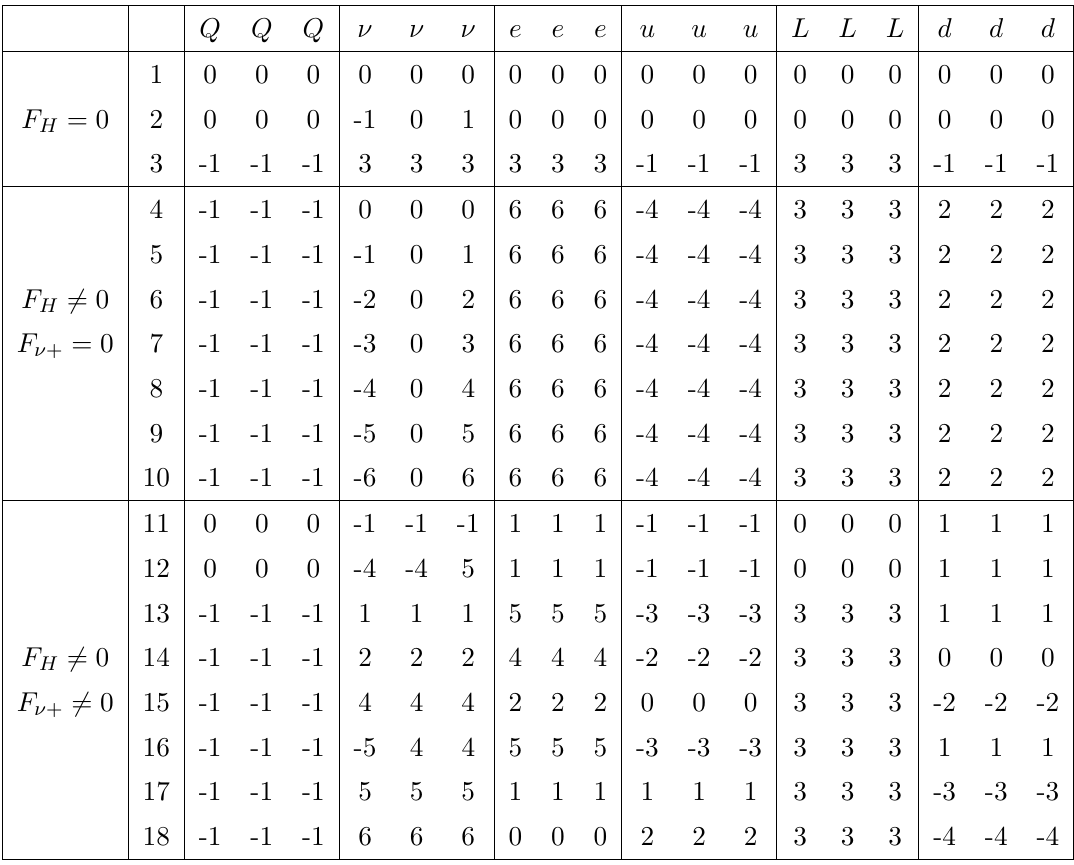
Table 6 . Inequivalent SM (cid:23) R U(1) F charges as output by the program which allow all possible renormalisable Yukawa couplings for SM fermions, for Q max = 6. The (cid:12)rst three solutions have F H = 0 whereas the rest have F H 6 = 0. The fourth to the tenth solutions have F (cid:23) + = 0, in which case the SM fermions must have U(1) F charge proportional to hypercharge; the fourth solution (in which the RH neutrinos have zero U(1) F charges and hence decouple from the ACCs) is in the same equivalence class as U(1) F charge equal to hypercharge for all